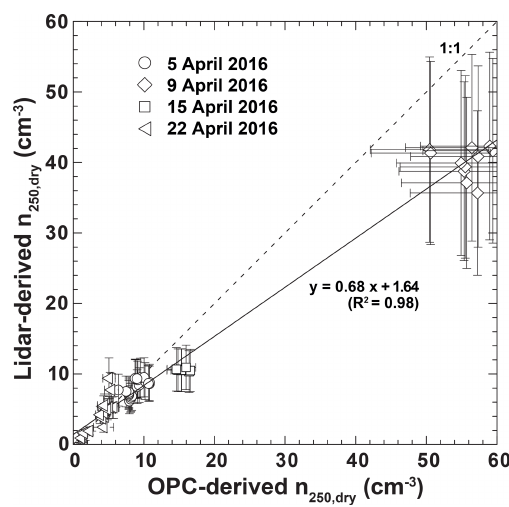
Figure 8. Correlation plot of n 250 , dry obtained from drone-based OPC measurements and inferred from lidar observations (values for a mixture of mineral dust and continental pollution, black in Fig. 7) during coordinated activities on 5, 9, 15 and 22 April 2016. The solid line marks the linear regression with the corresponding func- tion and squared correlation coefficient given in the plot. The 1 : 1 line is given as a dashed